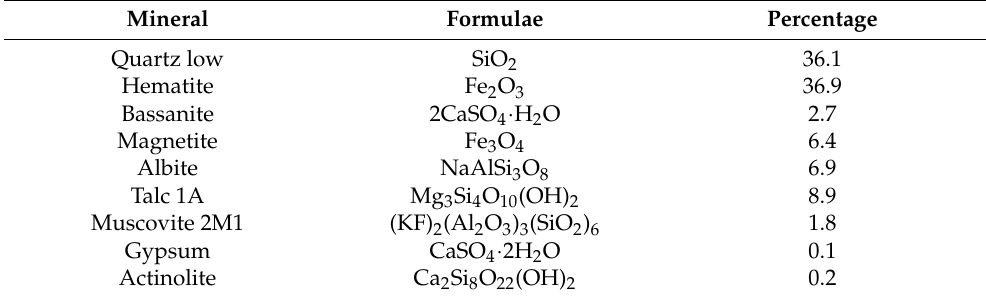
Table 4. XRD analysis